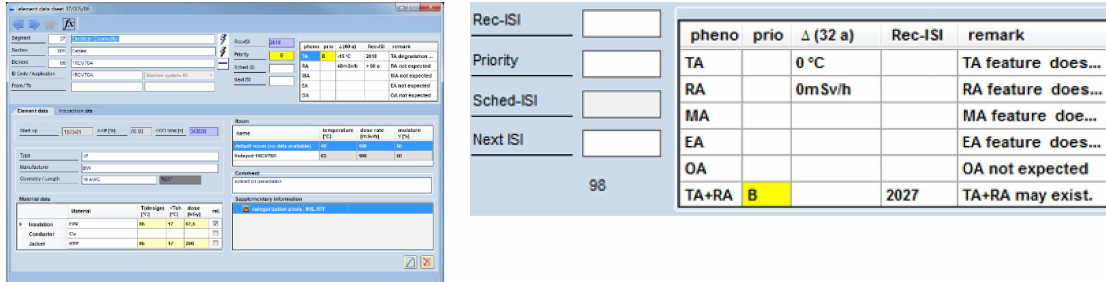
Fig. 4. Component data sheet window (at the left side) and zoom on the evaluation of the duration life of a cable according to the exposure conditions (at the right